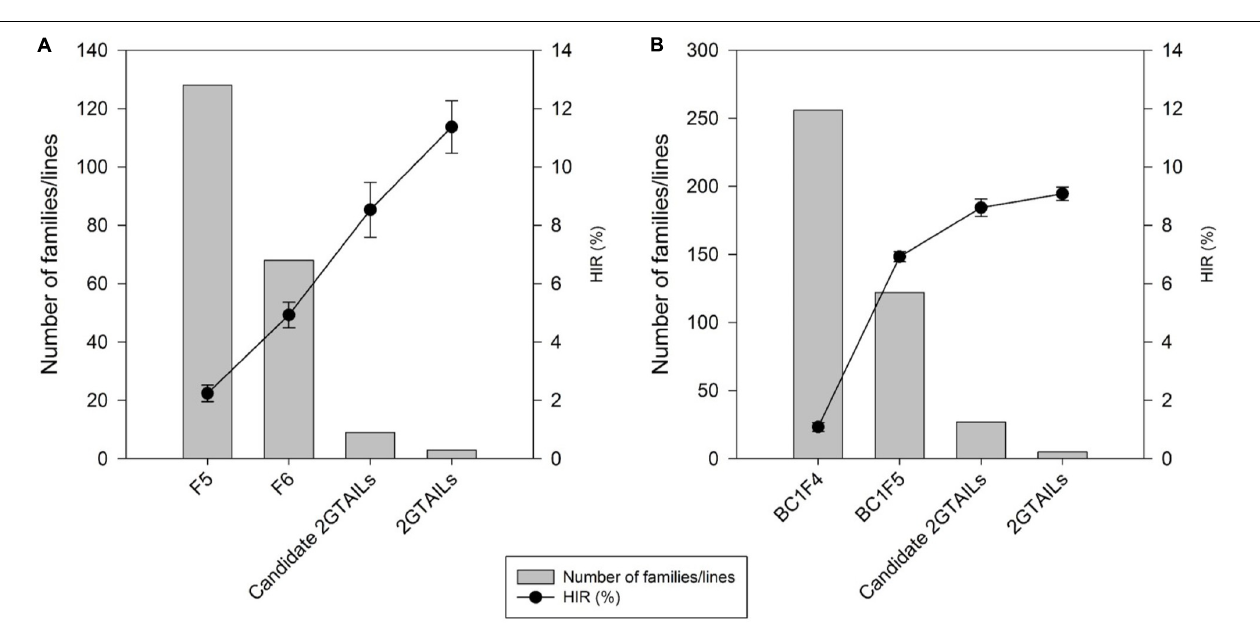
FIGURE 3 | Number of families/lines advanced and evaluated for HIR and the improvement of HIR with selection in the advanced generations of (A) the F2 strategy; and (B) the BC1